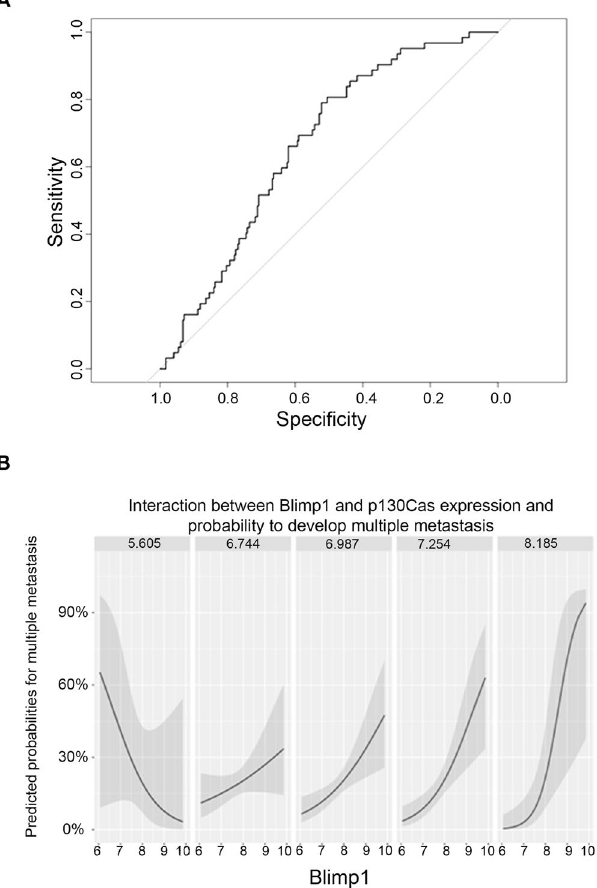
Figure 7. The interaction between Blimp1 and p130Cas levels positively correlates with the risk of developing multiple metastases. ( A ) ROC curve representing the prediction results of the logistic regression that discriminates between patients with single or multiple metastases using PRDM1 and BCAR1 expression levels and their interaction as predictors. ( B ) Effects plots of the regression. A separate plot of the fit is depicted for different levels of BCAR1, from left to right respectively: minimum, 1 st quartile, median, 3 rd quartile and maximum. In presence of higher expression of BCAR1, the effect of PRDM1 levels on the predicted probabilities becomes positive and progressively